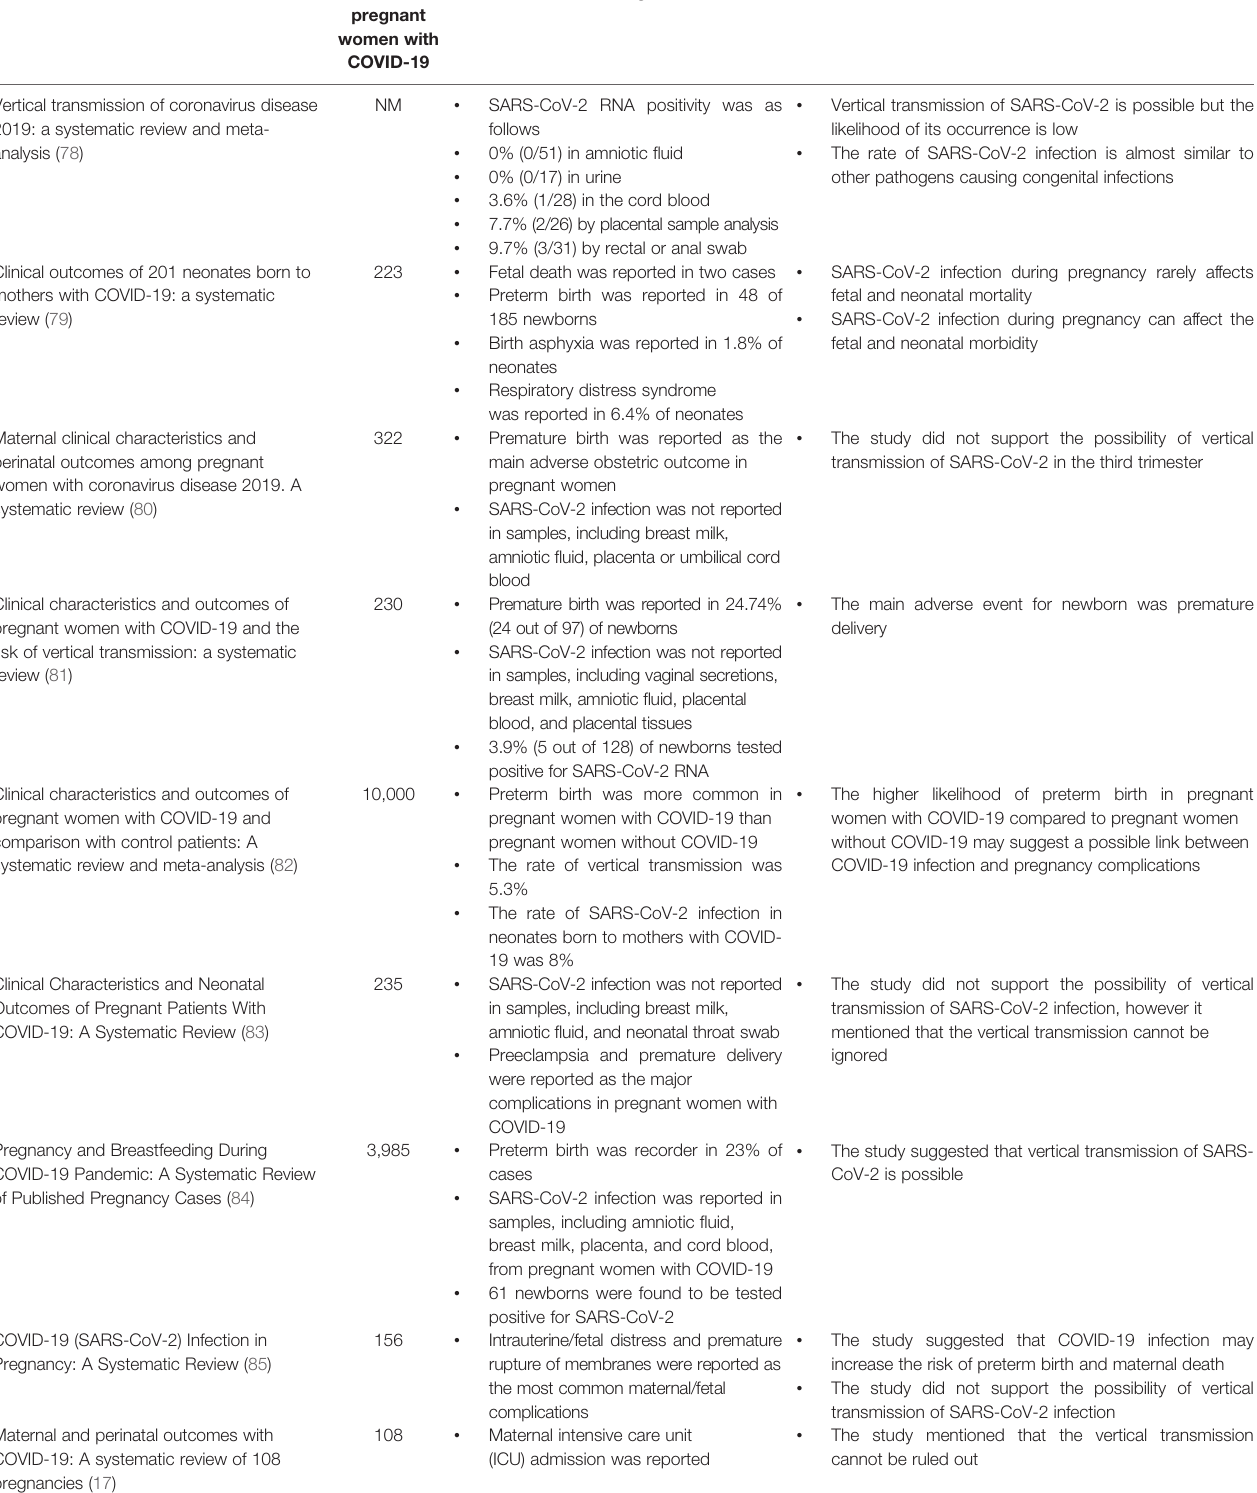
TABLE 1 | Systematic review and meta-analysis studies on COVID-19 infection during